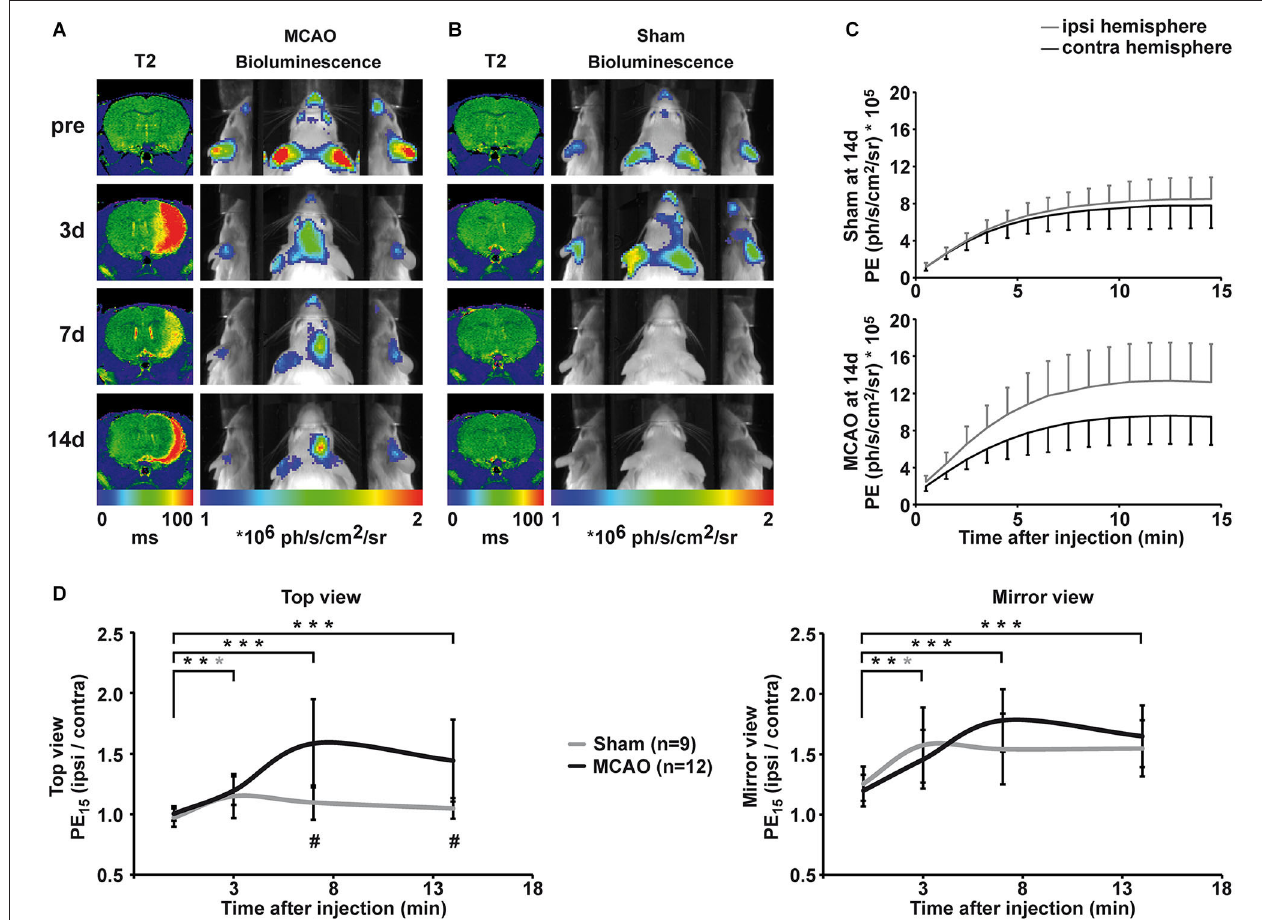
PE from the ipsilateral side, which was best visible in the mirror system. ( C) BLI kinetics of the ischemic and the intact hemisphere at 14d post sham surgery (upper graph) and MCAO surgery (lower graph). (D) Quantification of BLI changes was achieved by normalization of PE from ipsi- to contralateral hemisphere for the top view (left graph) and the mirror view (right graph). Pre-stroke PE was consistently equal in all investigated groups with a stronger variation in the mirror view. Increased PE was significantly different to pre-stroke values on day three for stroke, but also for sham animals in both views. At 7d and 14d, elevated PE in stroke animals was statistically significant compared to pre-stroke values (both p < 0.001) and to the sham group ( p = 0.001, p = 0.004). (black = stroke, gray = sham, * p < 0.05, ** p < 0.01, *** p < 0.001; # comparison between groups p <